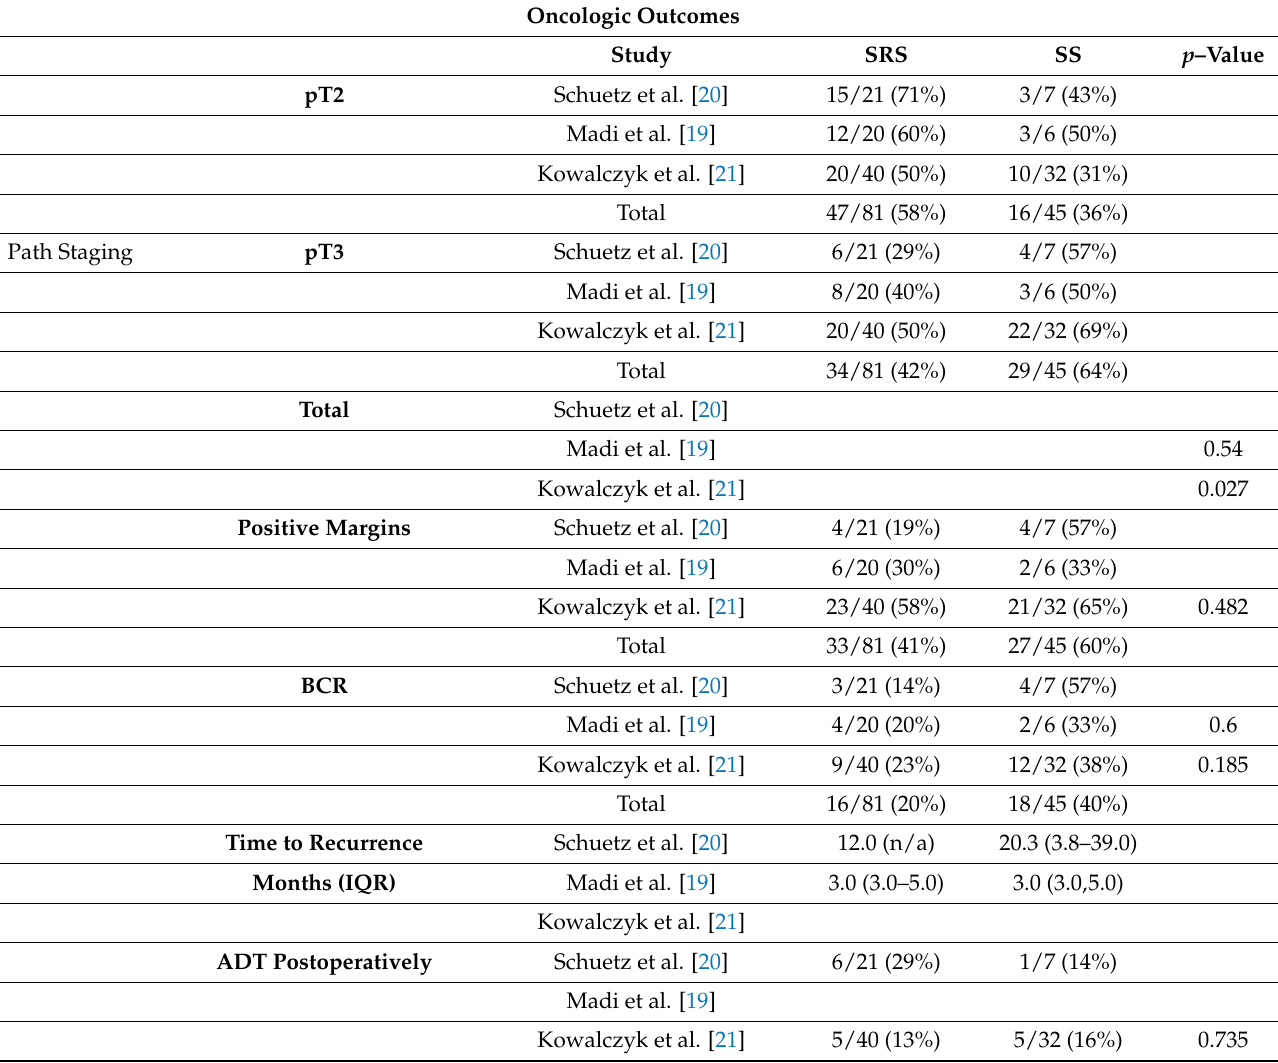
Table 4. Oncologic Outcomes. 42% of patients had pT2 disease in SRS, compared to 36% in SS. 42% had pT3 disease in SRS compared to 64% in SS. There was a 41% positive margin rate in SRS compared to 60% in SS. Biochemical recurrence (BCR) was seen in 20% of SRS vs. 40% of SS. Time to recurrence was 12.0 months vs. 20.3 months (IQR 3.8–39.0) in Schuetz et al. [20] and 3.0 months (IQR 3.0–5.0) for both SRS and SS in Madi et al. [19] Use of postoperative ADT was 29% vs. 14% in SRS and SS, respectively in Schuetz et al. [20] and 13% vs. 16% in Kowalczyk et al. [21]. Oncologic